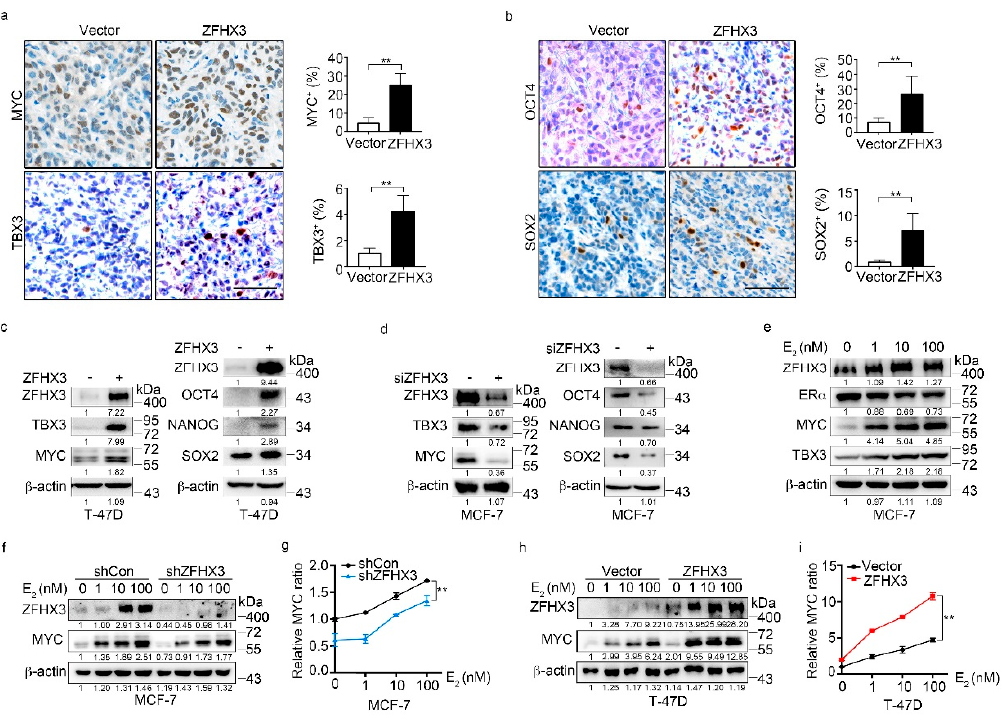
Figure 3. ZFHX3 induces the expression of MYC and TBX3 in ER + MCF-7 and T-47D breast cancer cells. ( a , b ) Detection of MYC, TBX3, OCT4, and SOX2 by IHC staining in xenograft tumors of T-47D cells ectopically expressing ZFHX3, as shown by representative IHC images (left) and quantification of cells with positive staining (right). Scale bar, 50 µ m. ( c , d ) Ectopic expression of ZFHX3 in T-47D cells increased ( c ), while ZFHX3 silencing in MCF-7 cells decreased ( d ), the expression of MYC, TBX3, OCT4, NANOG, and SOX2, as detected by western blotting analysis. ( e ) Estrogen (E 2 ) increased MYC and TBX3 in MCF-7 cells, as detected by western blotting. ( f – i ) ZFHX3 silencing in MCF-7 cells attenuated, while ectopic expression of ZFHX3 in T-47D cells enhanced, E 2 -mediated MYC expression, as detected by western blotting ( f , h ) and quantified by relative MYC ratio ( g , i ). Cells were treated with E 2 for 24 h at the indicated concentrations. siCon, control siRNA; siZFHX3, siRNA against ZFHX3 . ** p < 0.01. ( a , b ) IHC staining was done in xenograft tumors. ( c – i ) cells were cultured in 2D plastic surface and examined with western blotting. Ratios of protein band intensities to those of their loading controls, with the control sample’s normalized to 1, are shown under western blot bands ( c – f , h ). Uncropped western blot images are available in Supplementary Figure S8.